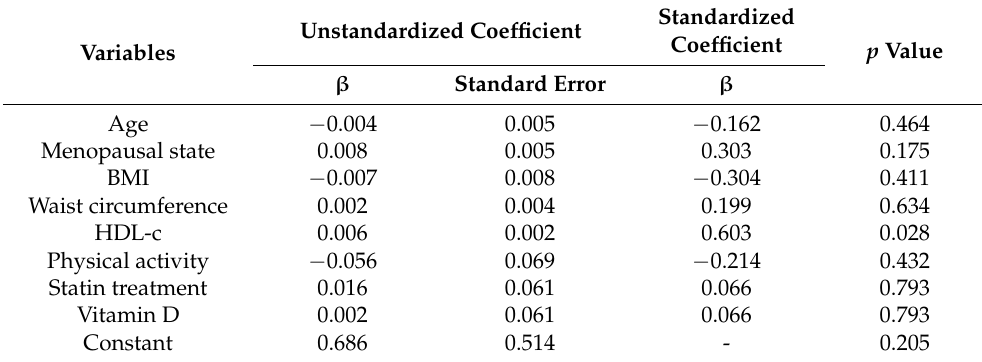
Table 3. Multivariate linear regression analyses for TBS